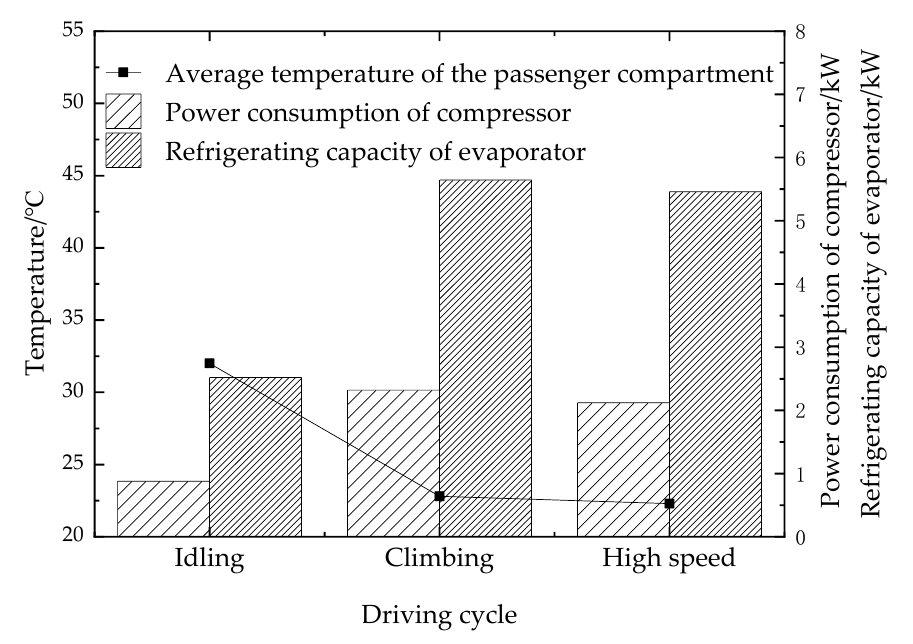
Figure 5. Comparisons of the refrigerating capacity of evaporator, power consumption of compressor and average temperature of passenger compartment under different working conditions.